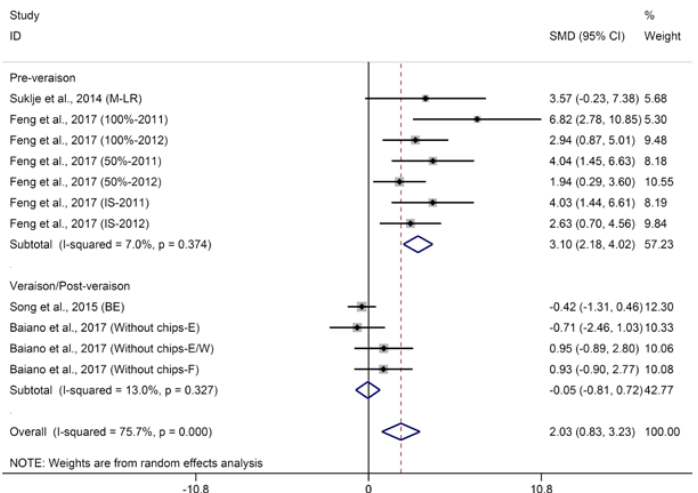
Figure 2. Meta-analysis for the effects of basal defoliation on linalool in wine, of which trials were categorized based on the timing of basal defoliation (pre-veraison and veraison/post-veraison).